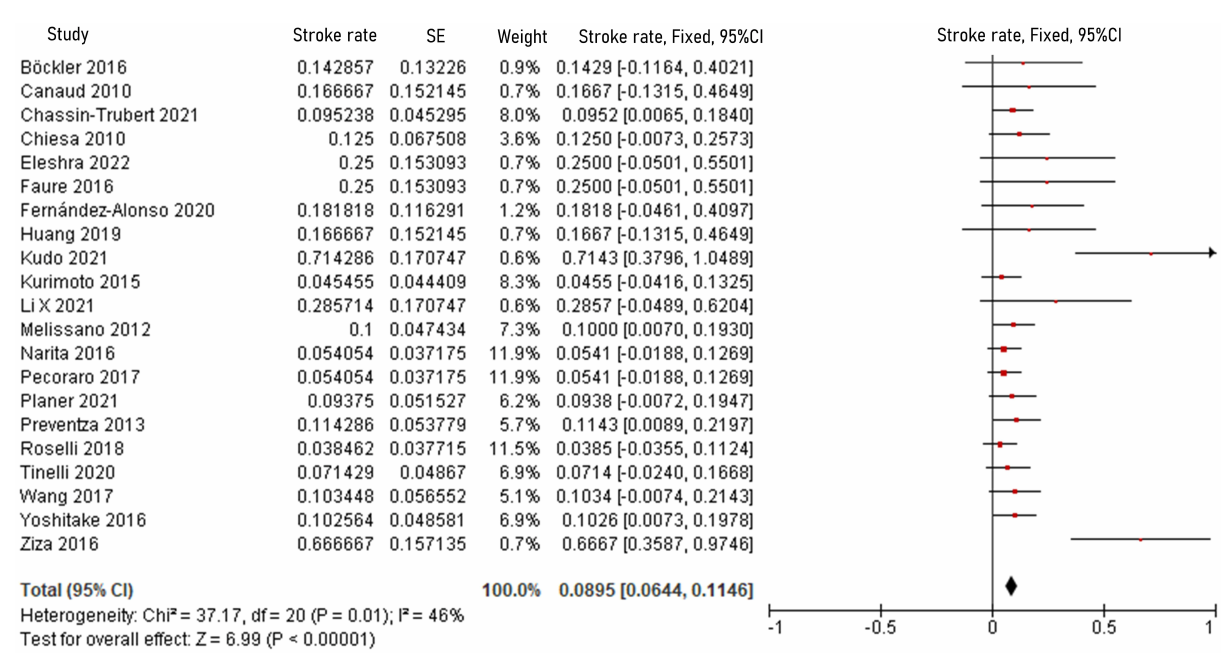
FIGURE4 Forest plot showing the fixed-effects proportion meta-analysis for post-operative stroke rate. CI, confidence interval; SE, standard error.